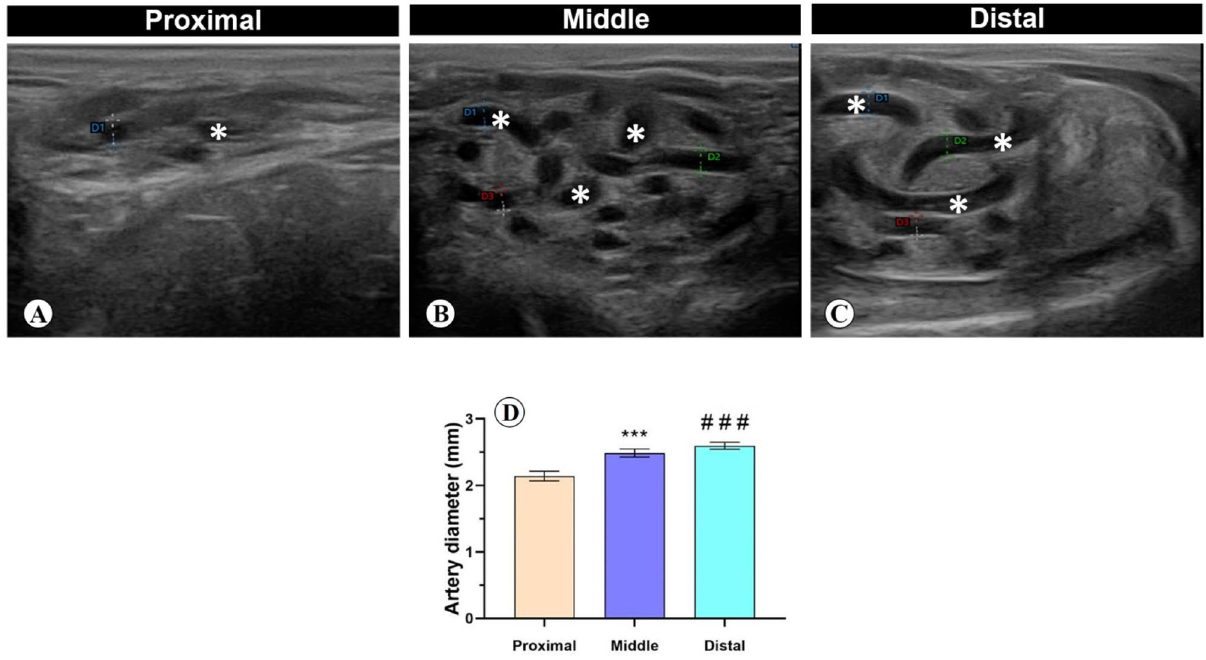
Figure 1. Cross section of the spermatic cord with B-mode ultrasonography. ( A ) Proximal, ( B ) middle, and ( C ) distal supratesticular zones of the testicular artery (stars). ( D ) Testicular artery diameter calculated by electronic caliper with B-mode ultrasonography in proximal, middle and distal supratesticular zones. ***p < 0.001 Middle versus Proximal zone; ### p < 0.001 Distal versus Proximal